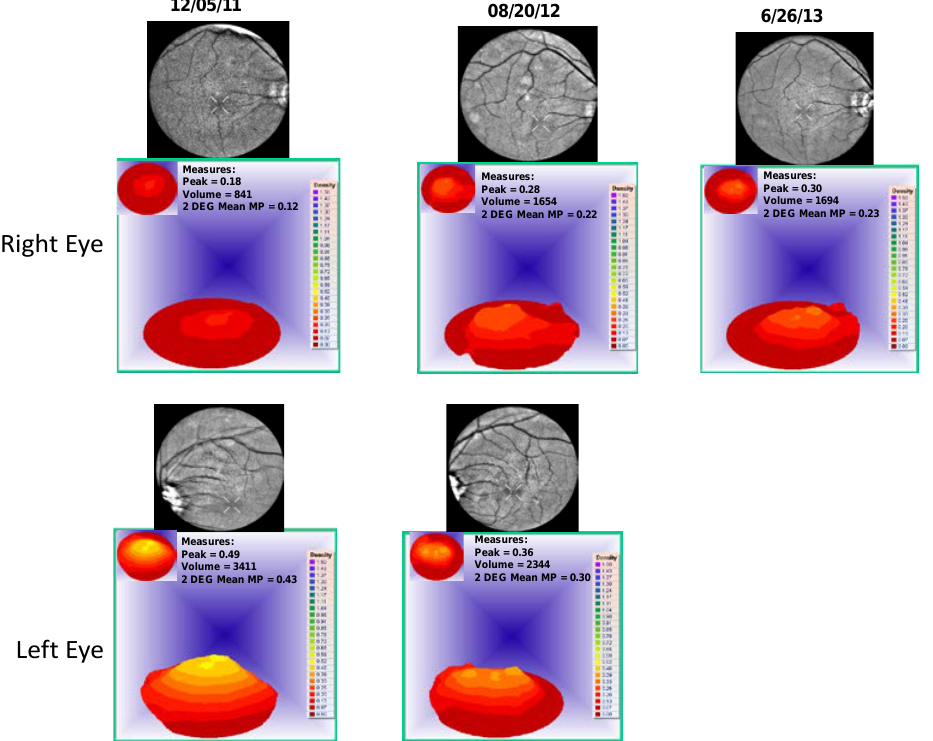
Figure 7. Visualized macular pigment volume of an 89-year-old male patient with AMD. No change in macular pigment over time in both retinas is seen. The patient could not focus on the marker to take 500 nm specular image of left retina on 26 June 2013.